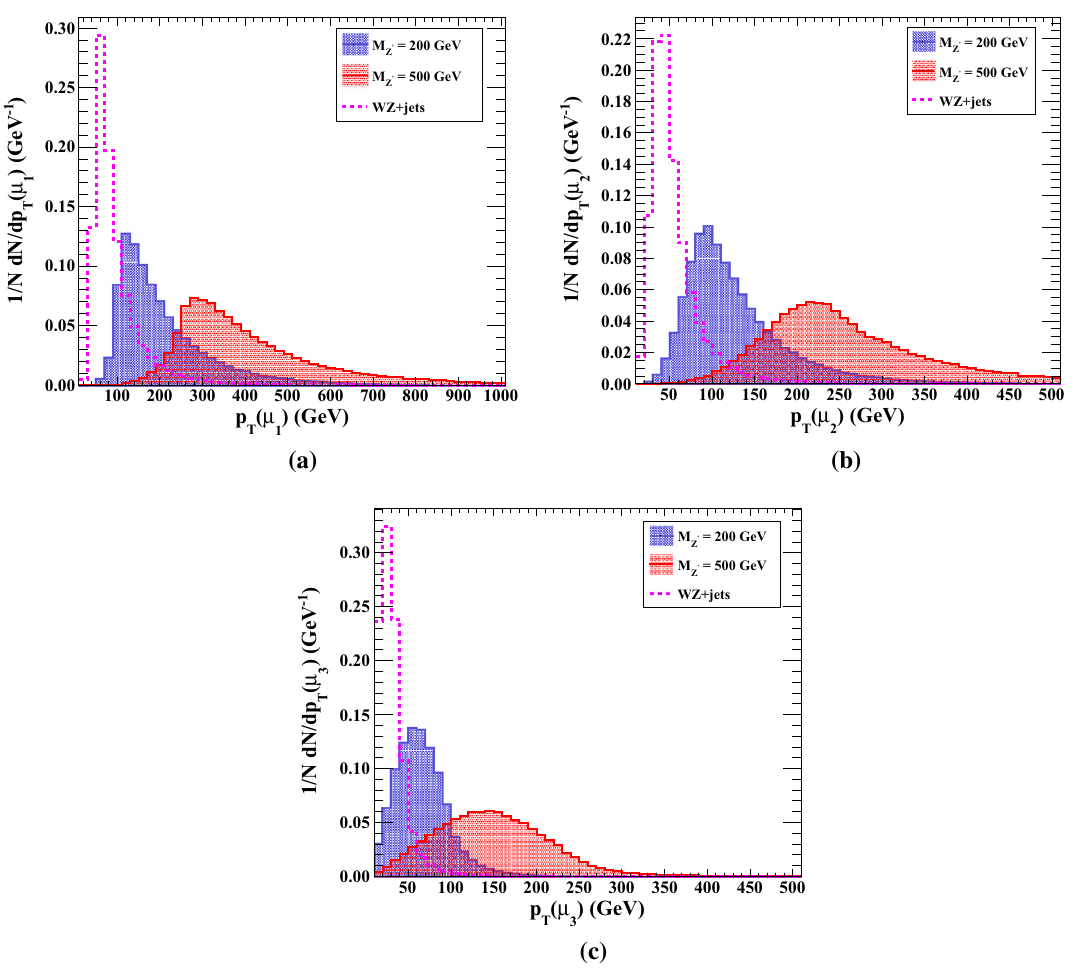
Fig. 10 Normalized transverse momentum ( p T ) distributions of the leading (10a), sub-leading (10b) and sub-sub-leading (10c) muons for the 3 μ + (cid:3) E T final state. Signal distributions are for M Z (cid:2) = 200 GeV,